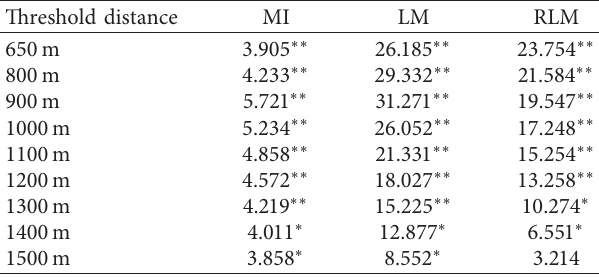
Table 5: Estimated variables using HPM models. Table 6: Autocorrelation tests based on spatial weight